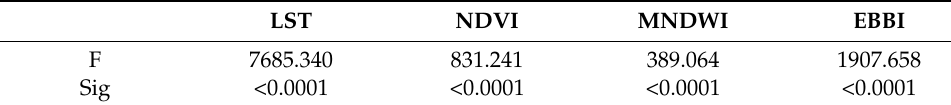
Table 8. Summary of ANOVA test results regarding the trend in annual changes in each of the LST, NDVI, MNDWI and EBBI indices in the main zones.